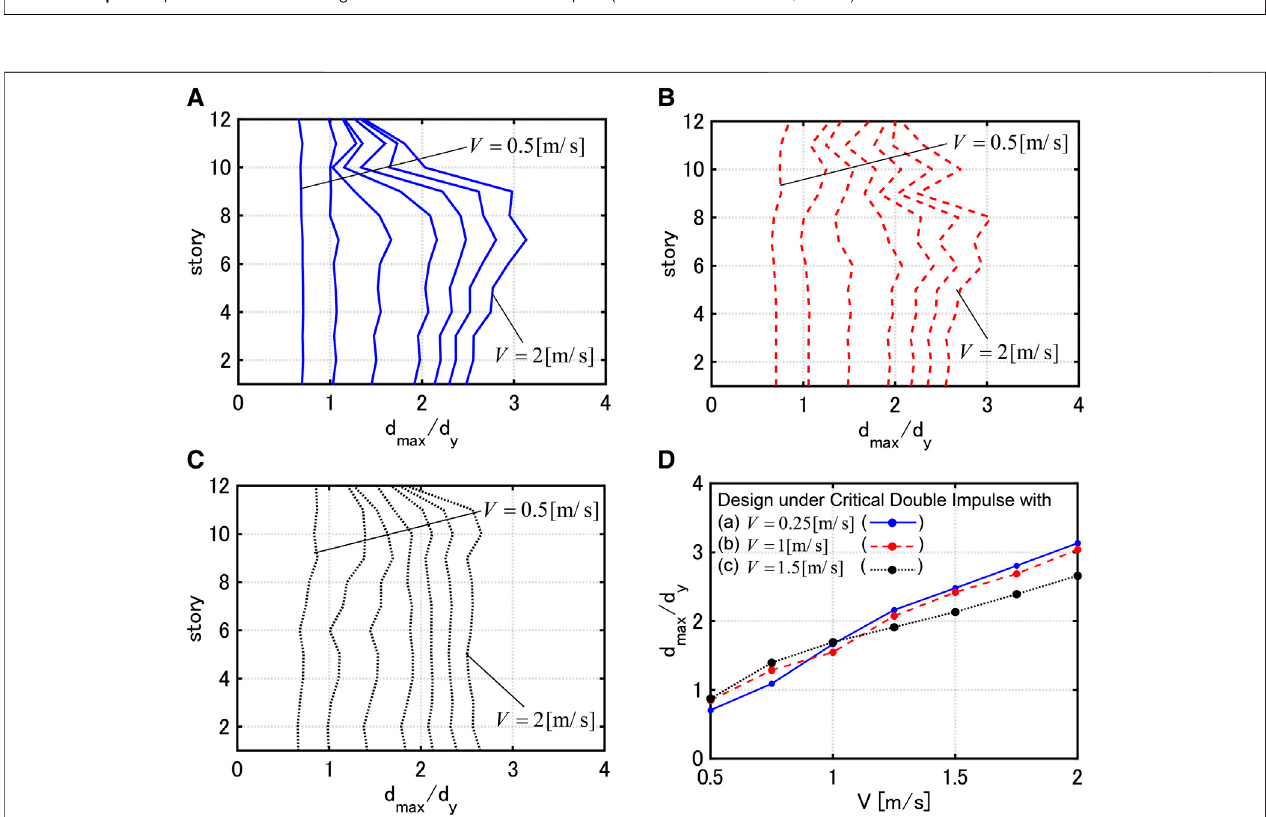
FIGURE7| DIPanalysisforthreemodels, (A) Modeldesignedfor V (cid:2) 0 . 25 [ m / s ] , (B) Modeldesignedfor V (cid:2) 1 . 0 [ m / s ] , (C) Modeldesignedfor V (cid:2) 1 . 5 [ m / s ] , (D) Comparison of maximum deformations for 3 models (Akehashi and Takewaki, 2020b).